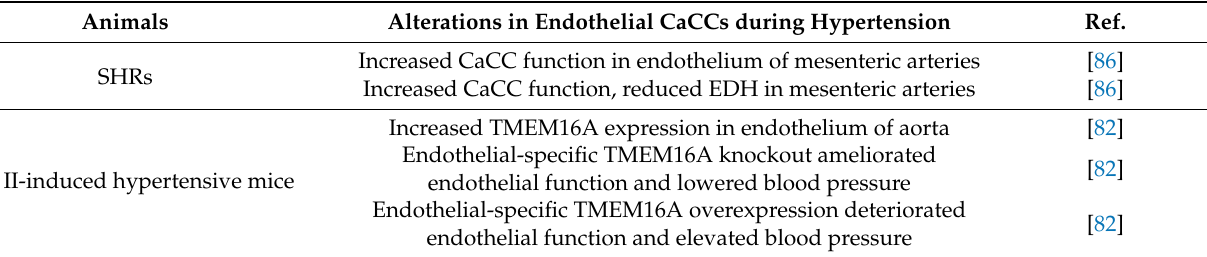
Table 2. Alterations in vascular endothelial Ca 2+ -activated Cl − channels during